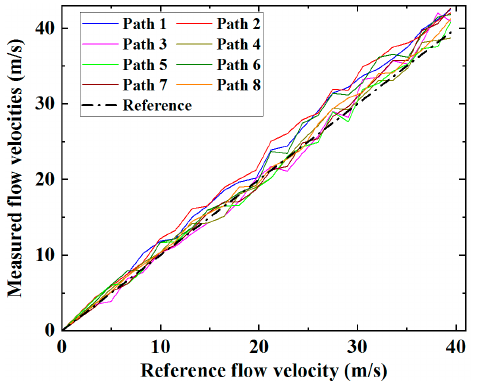
Figure 6. 𝑇𝑜𝐹𝑠 for ultrasonic waves travelling through the eight paths upstream and downstream at different flow velocities.